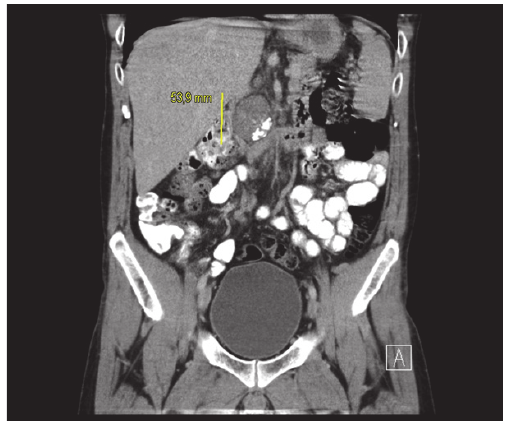
Figure 3: Abdominal CT scan showing a 5 × 6 cm mass with several calcifications between abdominal aorta and vena cava below the left renal vein: location is identical with metastatic site at first